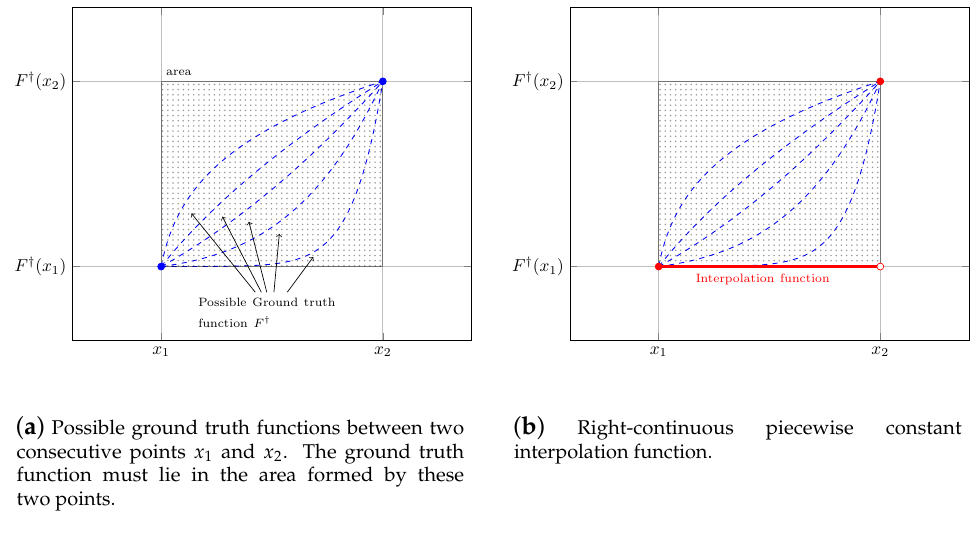
( a ) Possible ground truth functions between two consecutive points x 1 and x 2 . The ground truth function must lie in the area formed by these two points. Figure 1. Possible ground truth functions between two consecutive points x 1 and x 2 , and our choice of piecewise constant